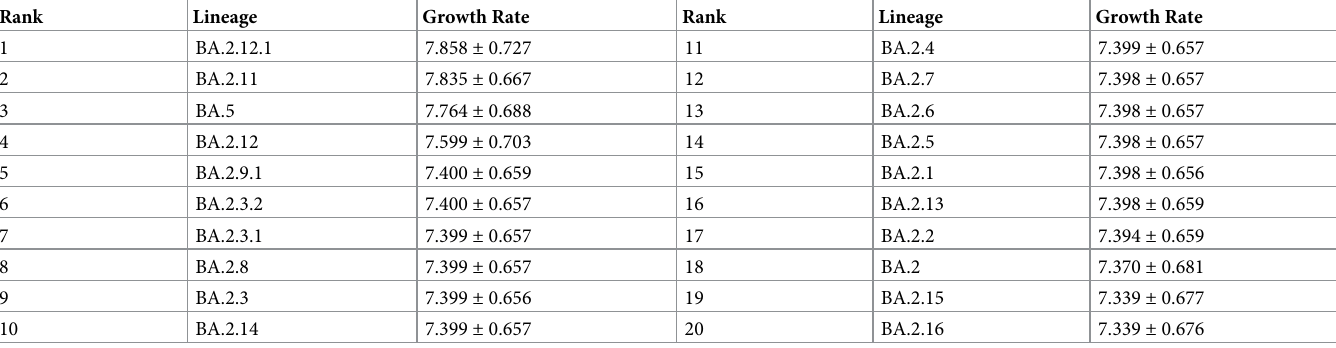
Table 1. Top 20 fittest SARS-CoV-2